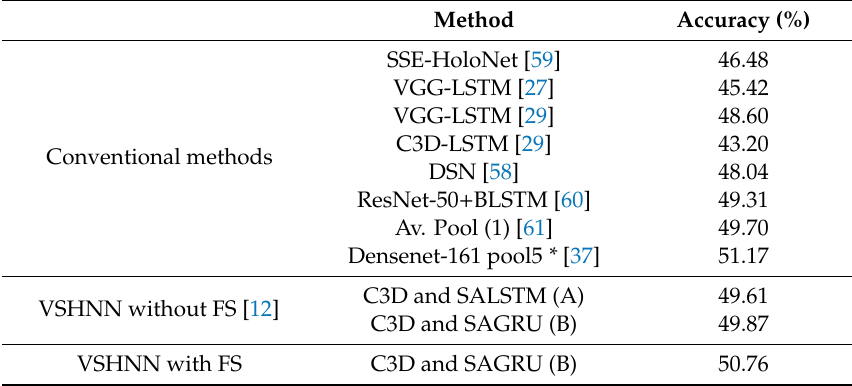
Table 3. Evaluation results for AFEW dataset. The letters in parentheses indicate the types of CNN-SARNN, and * means that the experimental method is five-fold cross-validation. VSHNN without FS module indicates